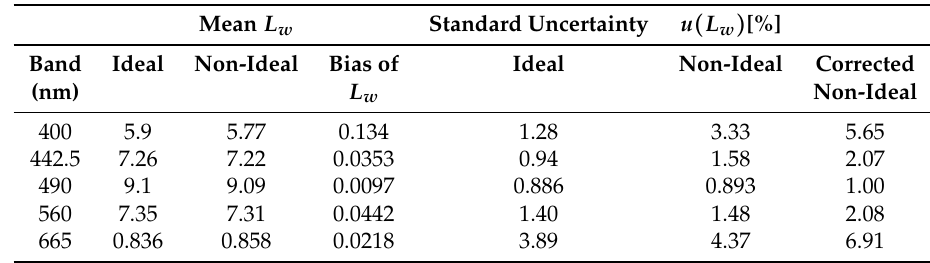
Table 5. The mean and standard uncertainty as a percentage of the mean of water-leaving